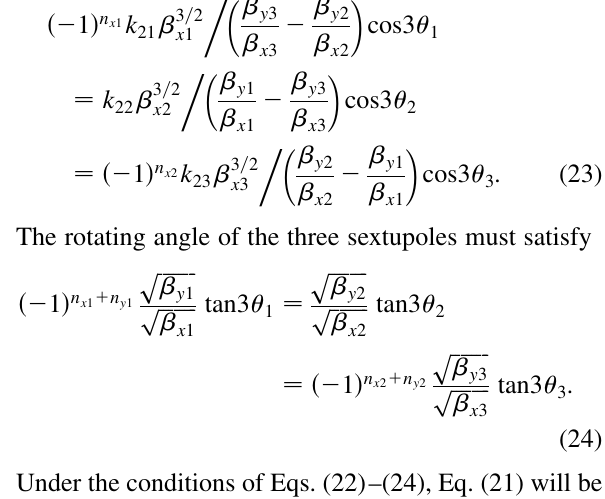
TABLE I. Number of multipoles for a self-cancellation